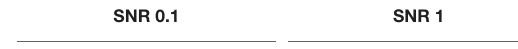
TABLE 1 | Ratios of “Quasi-Target”/“to-Target” and “Quasi-Distractor”/“to- Distractor” saccades. SNR